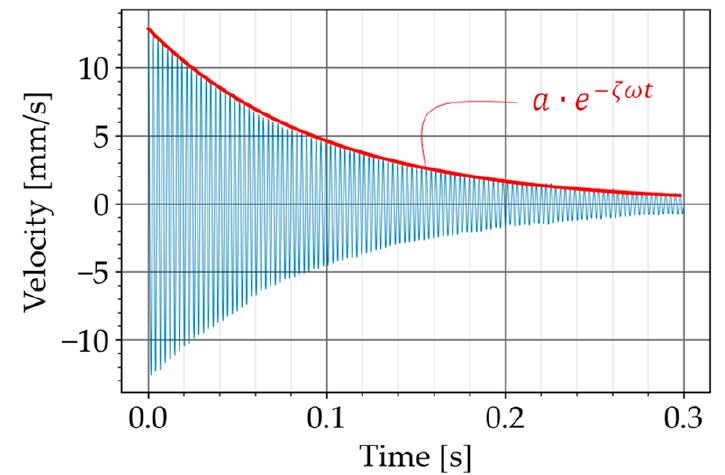
Figure 10. The decay of the free vibration and the fitting curve shown in red.